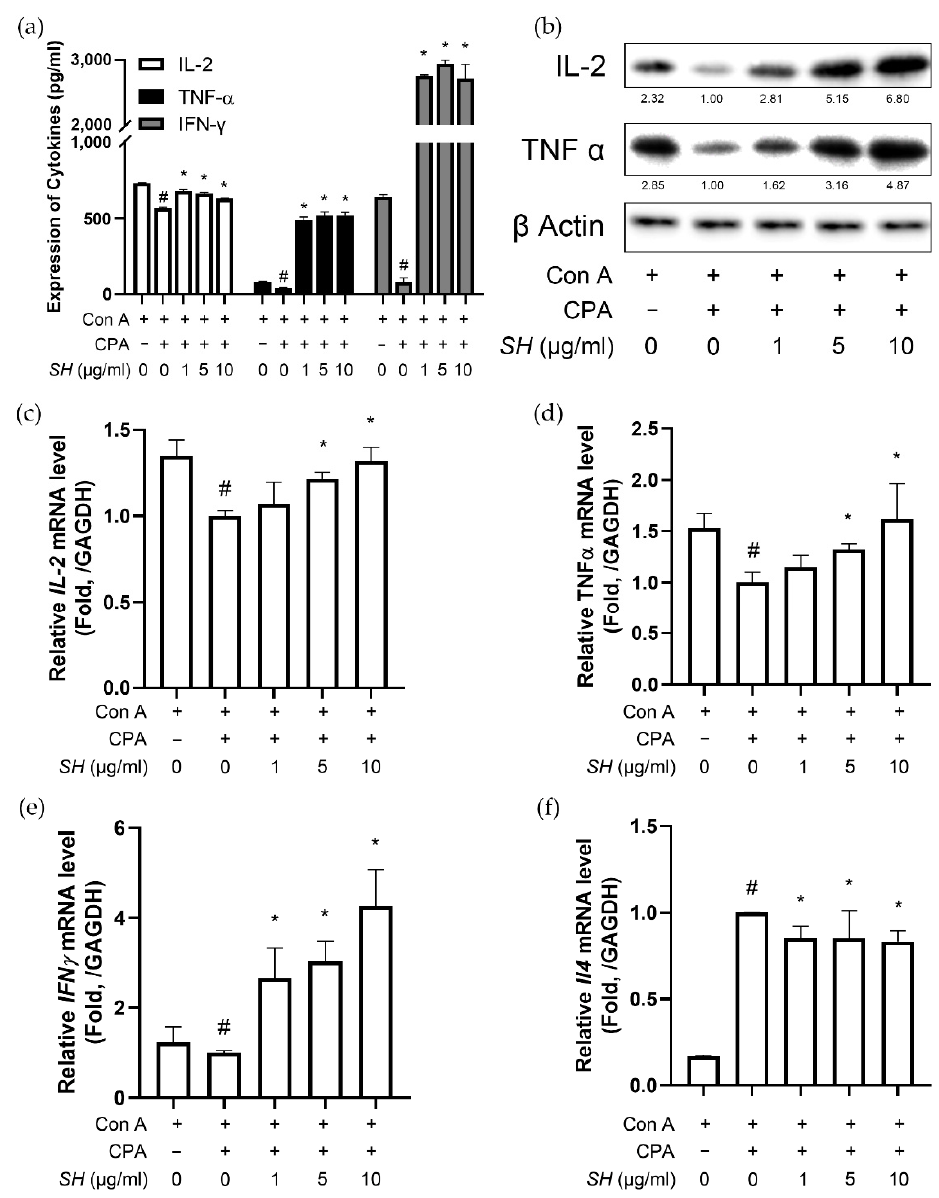
Figure 8. Effects of SH on cytokine expression in splenocytes. Splenocytes isolated from naïve mice were treated with various concentrations of SH. Then, the cytokine expression of (a) IL-2, TNF- α and IFN- γ was measured using the ELISA method. ( b ) Protein levels of cellular IL-2 and TNF- α were measured by Western blotting. mRNA levels of ( c ) Il2 , ( d ) Tnfa , ( e ) Ifng and ( f ) Il4 were meas- ured by real-time RT-PCR. # p < 0.05 vs. Con A-treated cells, * p < 0.05 vs. Con A/CPA-treated cells. Results are displayed as mean ± SD of three or more separate experiments.